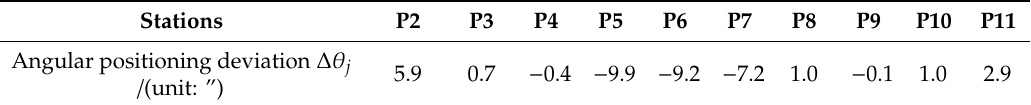
Table 3. Angular positioning deviation of the rotary table obtained by experiments.